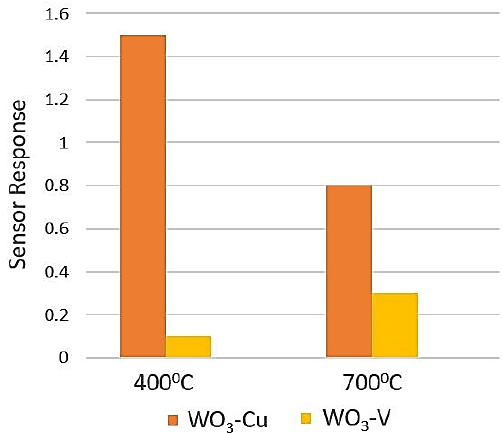
Figure 19. Sensor response of WO 3 -Cu (operating temperature 200 °C) and WO 3 -V (operating temperature 300 °C) annealed at 400 °C and 700 °C towards 100 ppm CO.